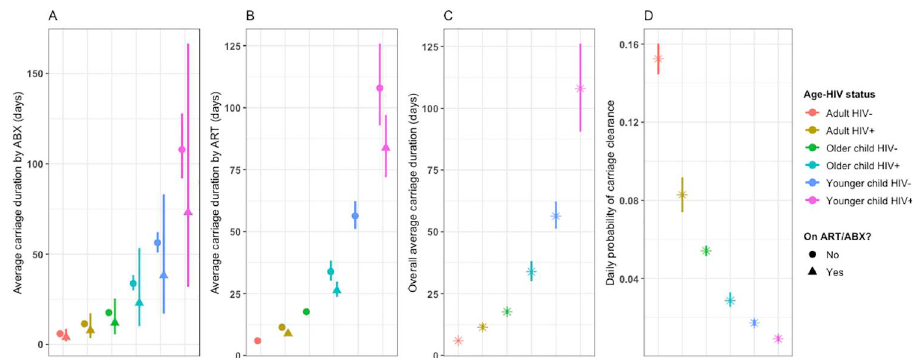
Fig 4. Duration of pneumococcal carriage in younger children ( < 5 years-old), older children (5–17 years-old) and adults ( � 18 years-old) in South African households between 2016–2018. Age and human immunodeficiency virus (HIV) stratified average carriage duration in days comparing individuals on antibiotics (ABX) (triangular shape) to those not on ABX (circular shape) (A), and individuals on antiretroviral therapy (ART) (triangle shape) to those not on ART (circle shape) (B). Age and HIV stratified overall average carriage duration in days (C). Age and HIV stratified daily probability of carriage clearance